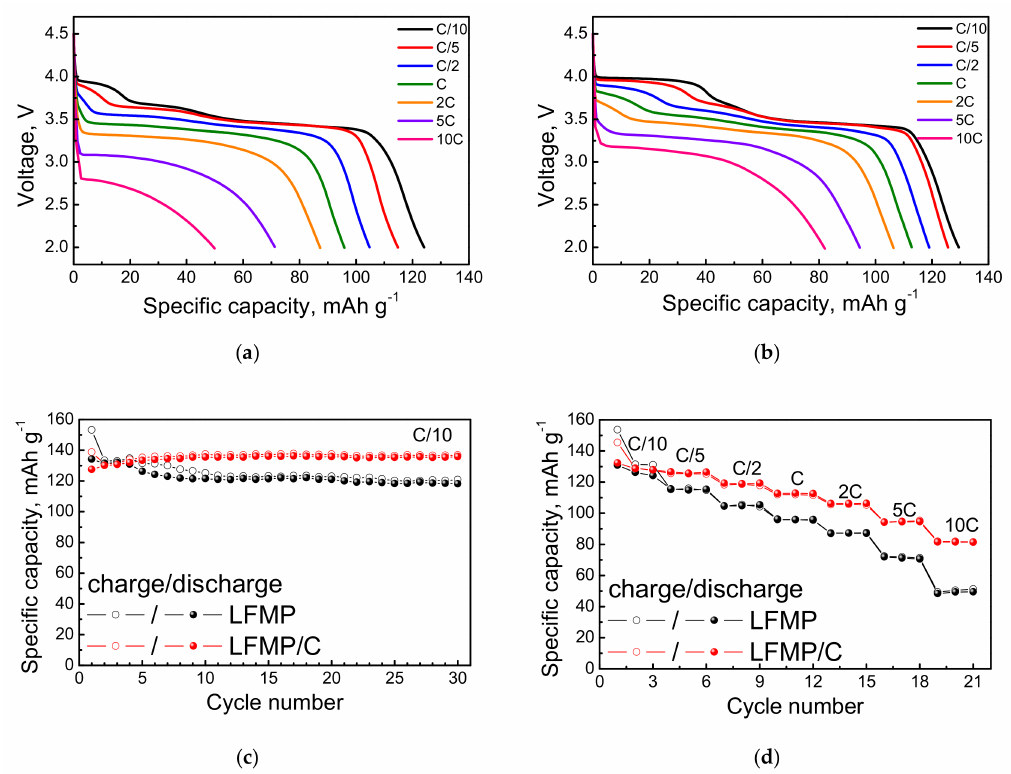
Figure 5. Discharge profiles of LFMP ( a ) and LFMP / C ( b ) vs. cycling rate in the 2.0–4.5 V range; charge / discharge capacity vs. cycle number ( c ) and cycling rate ( d ).